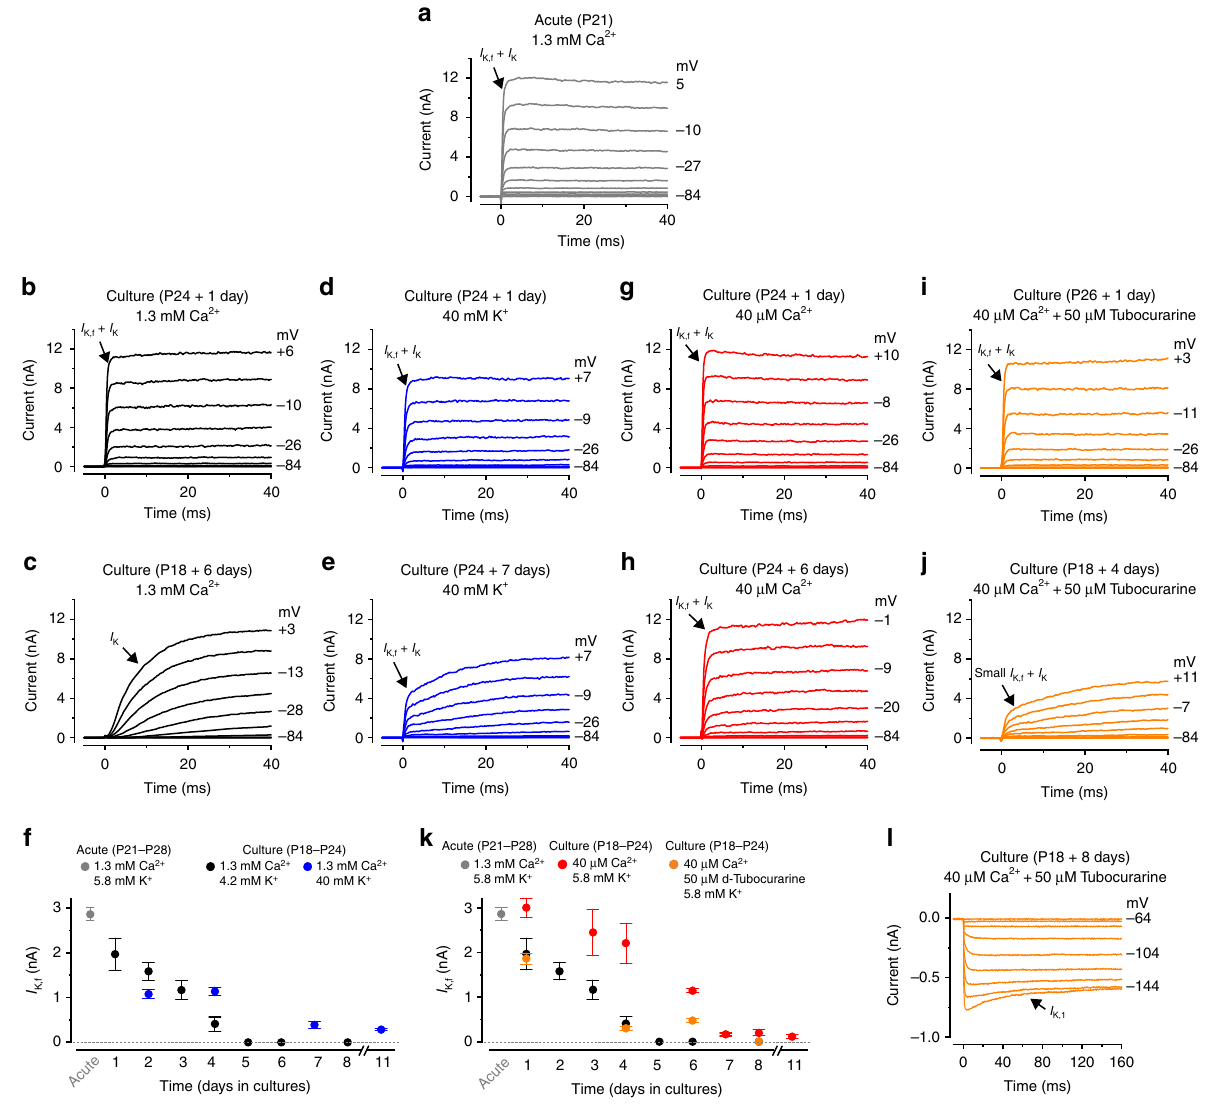
Fig. 6 The resting MET current drives the maintenance of mature IHC K + currents in cochlear cultures. a Potassium outward currents recorded from a P21 IHC of an acutely dissected gerbil cochlea. Recordings were performed using a perilymph-like solution (1.3 mM extracellular Ca 2 + ; 5.8 mM K + ). Currents were elicited using 10 mV depolarizing voltage steps from − 84 mV. Note the fast activating I K,f characteristic of adult IHCs (arrow). b , c Currents recorded from IHCs maintained in cochlear culture for 1 day ( b ) or 6 days ( c ). The culture medium bathing the cochlea (see Methods) contained 1.3 mM Ca 2 + and 4.2 mM K + . d , e Currents recorded from IHCs maintained in culture for 2 day ( d ) or 7 days ( e ). Culture medium contained 1.3 mM Ca 2 + and 40 mM K + . f Size of I K,f recorded from IHCs of acutely isolated gerbil cochleae (gray circle, n = 6, P21-P28, 3 gerbils) or maintained in culture. Culture conditions were: (1) normal medium (black circles, number of IHCs from left to right: 7,3,4,10,2,6,7; from 9 cochlear cultures; gerbil age at the day of culturing: P18-P24); 2) medium supplemented to 40 mM K + (blue circles, number of IHCs: 6,6,5,7, from 4 cochlear cultures, P18-P24). g , h Currents recorded from IHCs maintained in culture for 1 day ( g ) or 6 days ( h ) with a medium containing 40 µ M Ca 2 + . i , j , l Currents from IHCs maintained in cochlear culture for 1 day ( i ), 4 days ( j ) or 8 days ( l ) with a medium containing 40 µ M Ca 2 + and 50 μ M of the MET channel blocker d-tubocurarine. The inward recti fi er K +